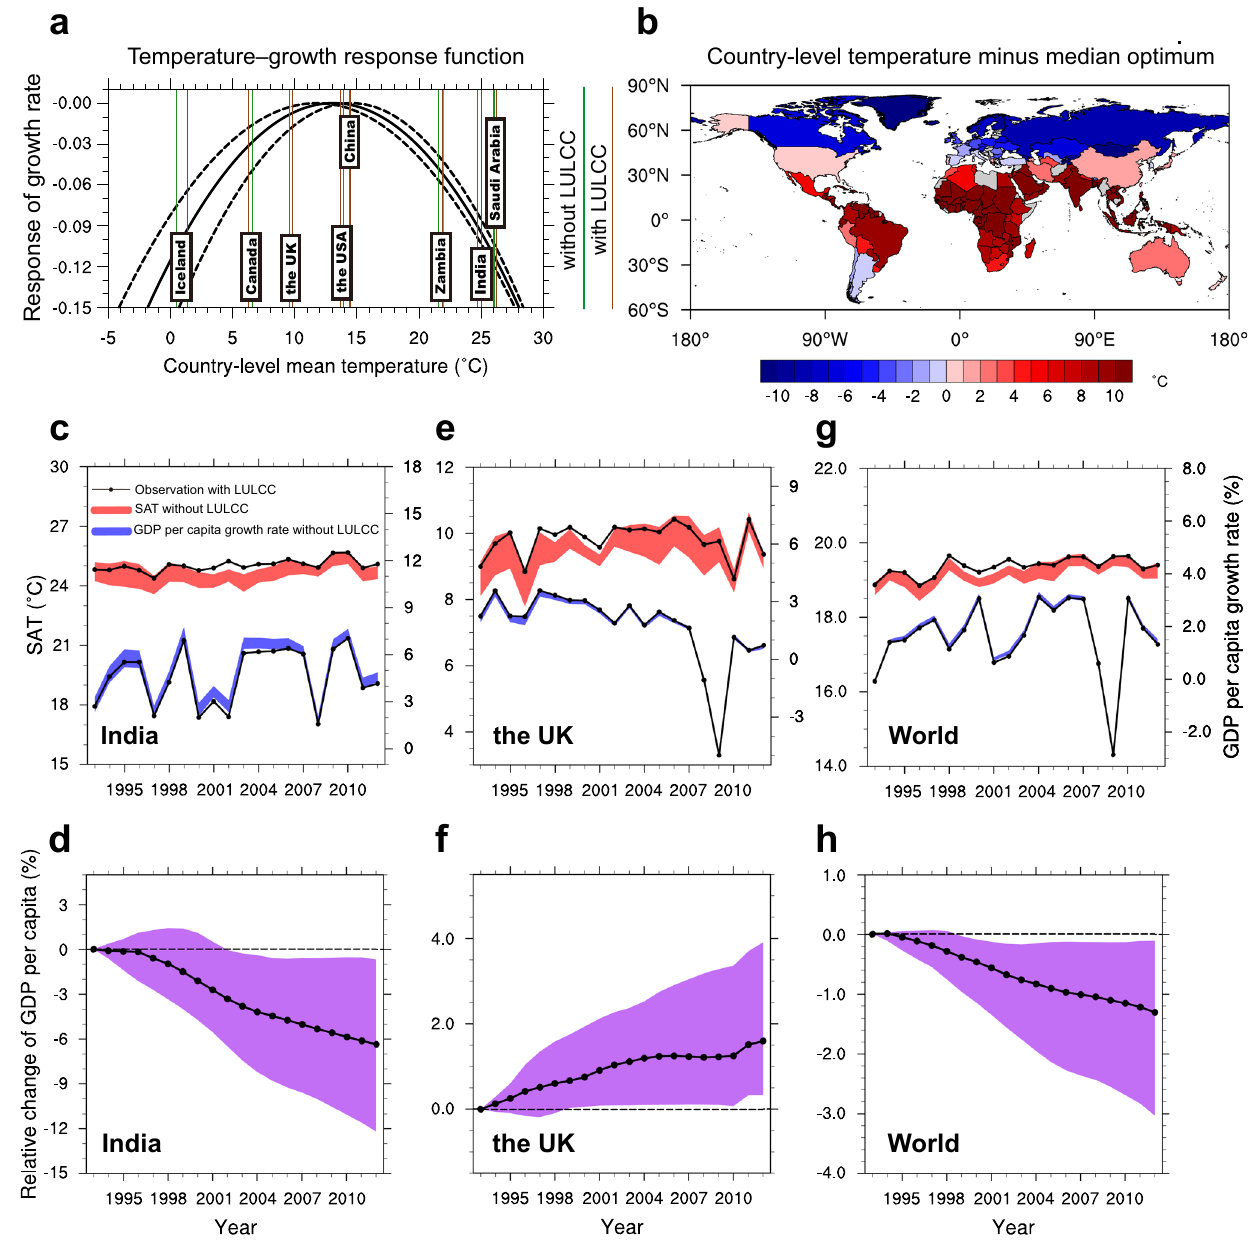
Fig. 4 Country-level annual-mean surface air temperature (SAT) changes and associated economic impacts during 1993 – 2012 due to the combined impacts of historical land-use and land-cover change (LULCC). a Bootstrapped temperature – growth response function represented by 25th (left dashed curve), 50th (solid curve), and 75th (right dashed curve) percentiles of 1000 members of the temperature optimum 27 . Vertical lines overlaid on the curves are annual mean temperatures from factual observations with LULCC (brown) and the counterfactual world without LULCC (green) for some representative countries. b Spatial pattern of the difference between the country-level annual mean temperature and median temperature optimum. Countries and regions with missing values are shaded in gray. c , e , g The 25 – 75th percentile range of SAT (red shading, in °C) and GDP per capita growth rate (blue shading, in %) in the counterfactual world without LULCC, both with corresponding observations in the factual world with LULCC (black dotted line) for ( c ) India, ( e ) the UK, and ( g ) the world. d , f , h Relative changes in GDP per capita (%) induced by LULCC for ( d ) India, ( f ) the UK, and ( h ) the world. The black dotted line and corresponding purple shading indicate the median and 25 – 75th percentile range of ensemble